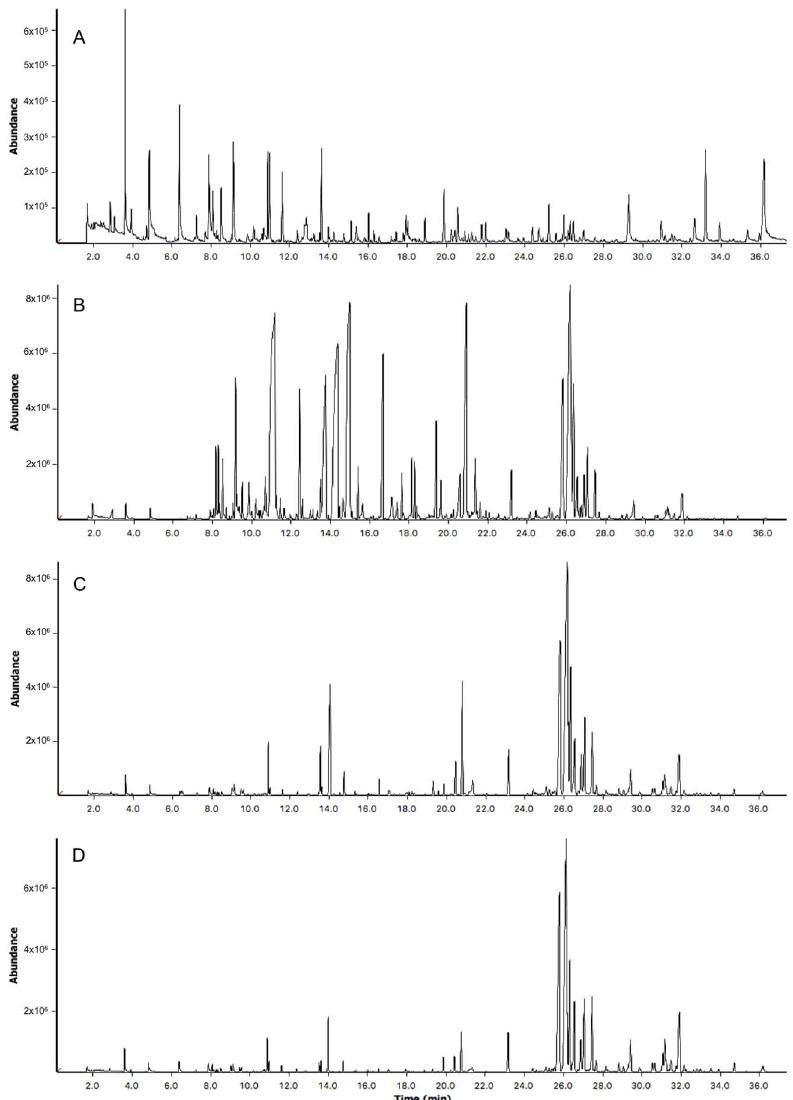
Figure 1. Overlaid total ion chromatograms showing recovered skin volatiles. ( A ) The baseline skin volatile profile; ( B ) the volatile profile immediately after fragrance application; ( C ) skin volatiles 1 h after fragrance application and ( D ) 2 h after fragrance application.